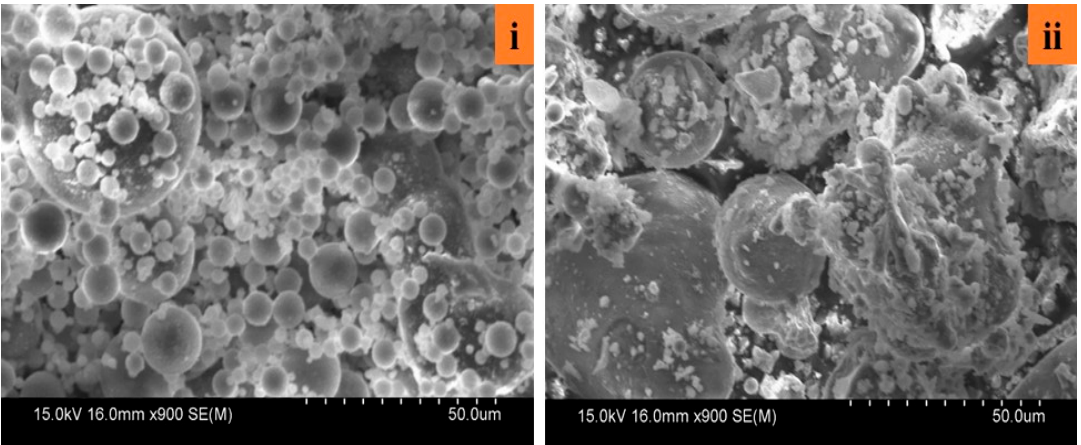
Figure 1. SEM images of fly-ash (i) and bottom-ash (ii).